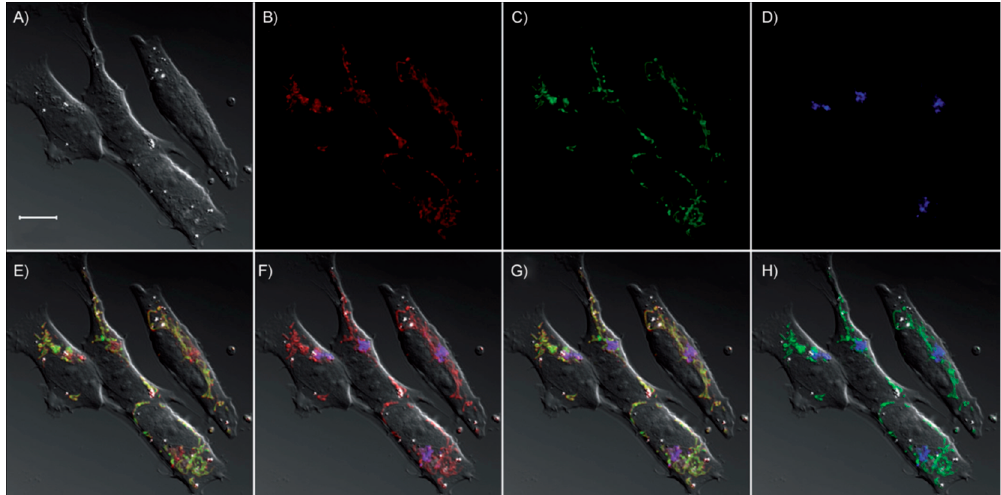
Figure 1. Representative confocal images of intracellular colocalization studies of probe 1 (10 µ M) incubated with live human SH-SY5Y cells co-stained with Mito-Tracker Green (100 nm) and LysoTracker Blue DND-22 (50 nM). ( A ) Differential interference contrast (DIC) image of cells. ( B ) 1 -Fe 3+ fluorescence collected at 547–703 nm (red). ( C ) MitoTracker fluorescence collected at 492–548 nm (green). ( D ) LysoTracker fluorescence collected at 409–484 nm (blue). ( E ) DIC image of ( A ) and fluorescence images of ( B ) and ( C ) were merged. Colocalization regions are in yellow, and non-overlapping regions remain in the red. ( F ) DIC image of ( A ) and fluorescence images of ( B ) and ( D ) were merged. Overlapping regions are in purple, and non-overlapping regions remain in the red. ( G ) Images of ( A ), ( B ), ( C ), and ( D ) were merged, revealing that the 1 -Fe 3+ images are 100% colocalized with the sum of those of MitoTracker and LysoTracker. ( H ) Images of ( A ), ( C ), and ( D ) were merged, showing no overlapping region between lysosomes and mitochondria. Scale bar = 10 mm (Reproduced from Ref. [11] with permission from Wiley).